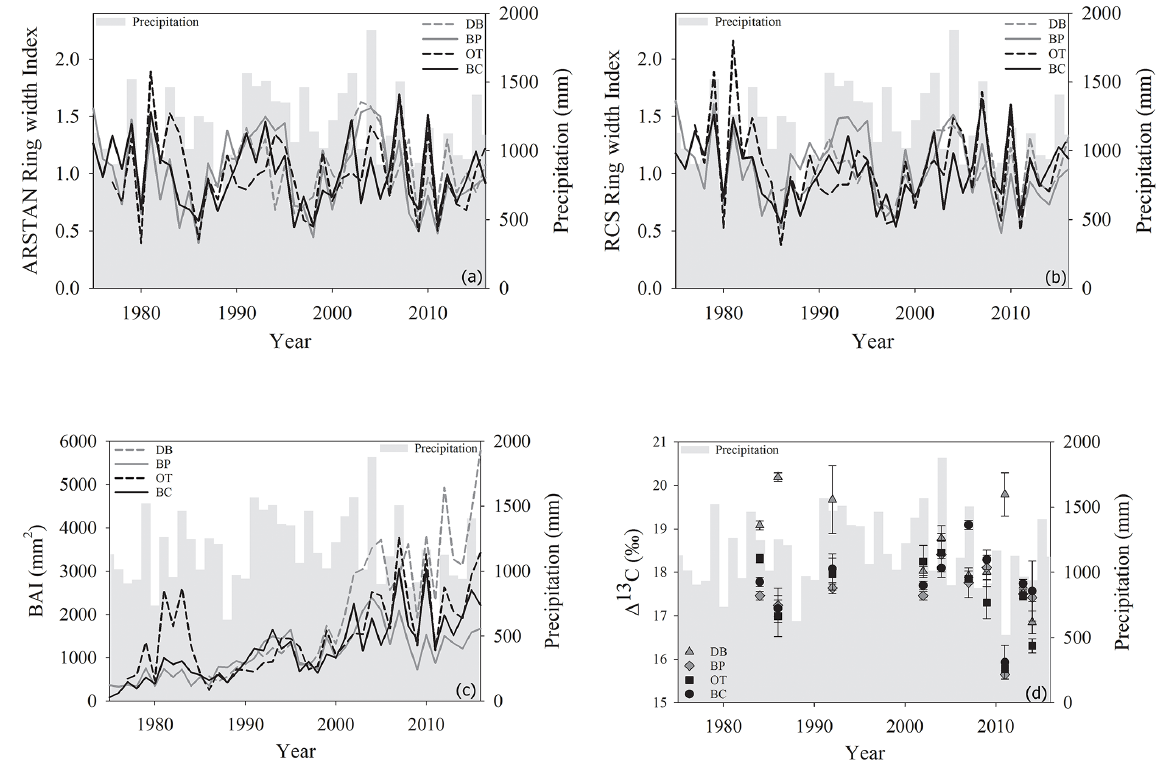
Figure 2. Temporal variation in (a) ARSTAN ring width index, (b) RCS ring width index, (c) basal area increments and (d) tree ring (cid:49) 13 C values of Quercus nigra in the Brazos–Colorado coastal basin of Texas. Total annual precipitation is shown by the gray shading.